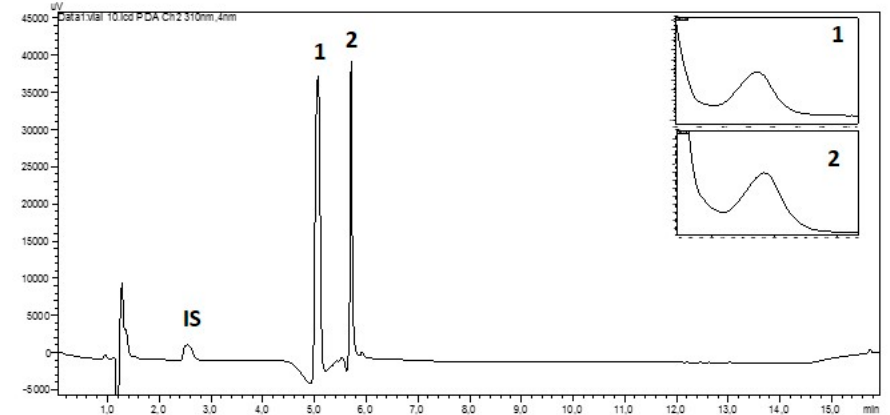
Figure 2. Hydrophilic interaction liquid chromatography (HILIC)-HPLC chromatogram of the aqueous extract from a sample of Dermatocarpon luridum var. luridum (voucher barcode JB/001/07/2012 ) recorded at 310 nm and inset UV-spectra of mycosporines 1 (Rt = 5.07 min) and 2 (Rt = 5.71 min) ( IS : Internal Standard added to D. luridum extract, x-axis : 0–16 min, y-axis : arbitrary units of absorbance). Quantification of mycosporines glutaminol and glutamicol was calculated using the calibration curves of the respective standards. Mycosporine glutamicol was found in 45 out of 48 collections